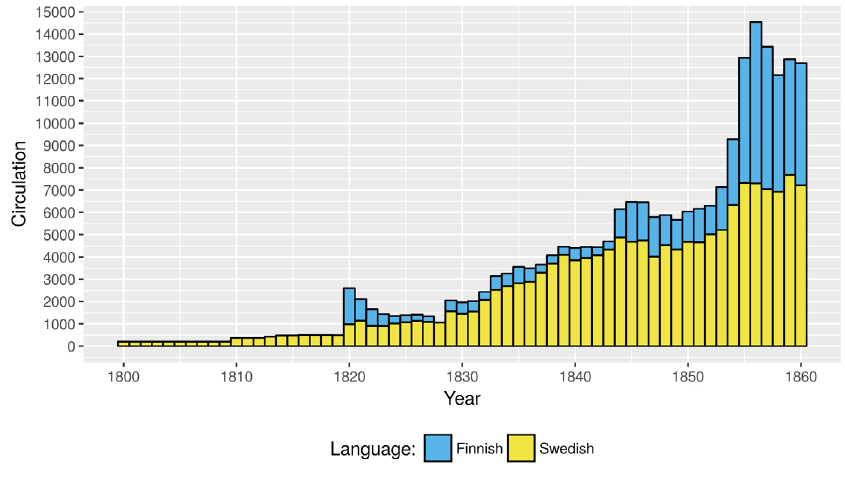
Fig. 4 The circulation of Finnish and Swedish newspapers per